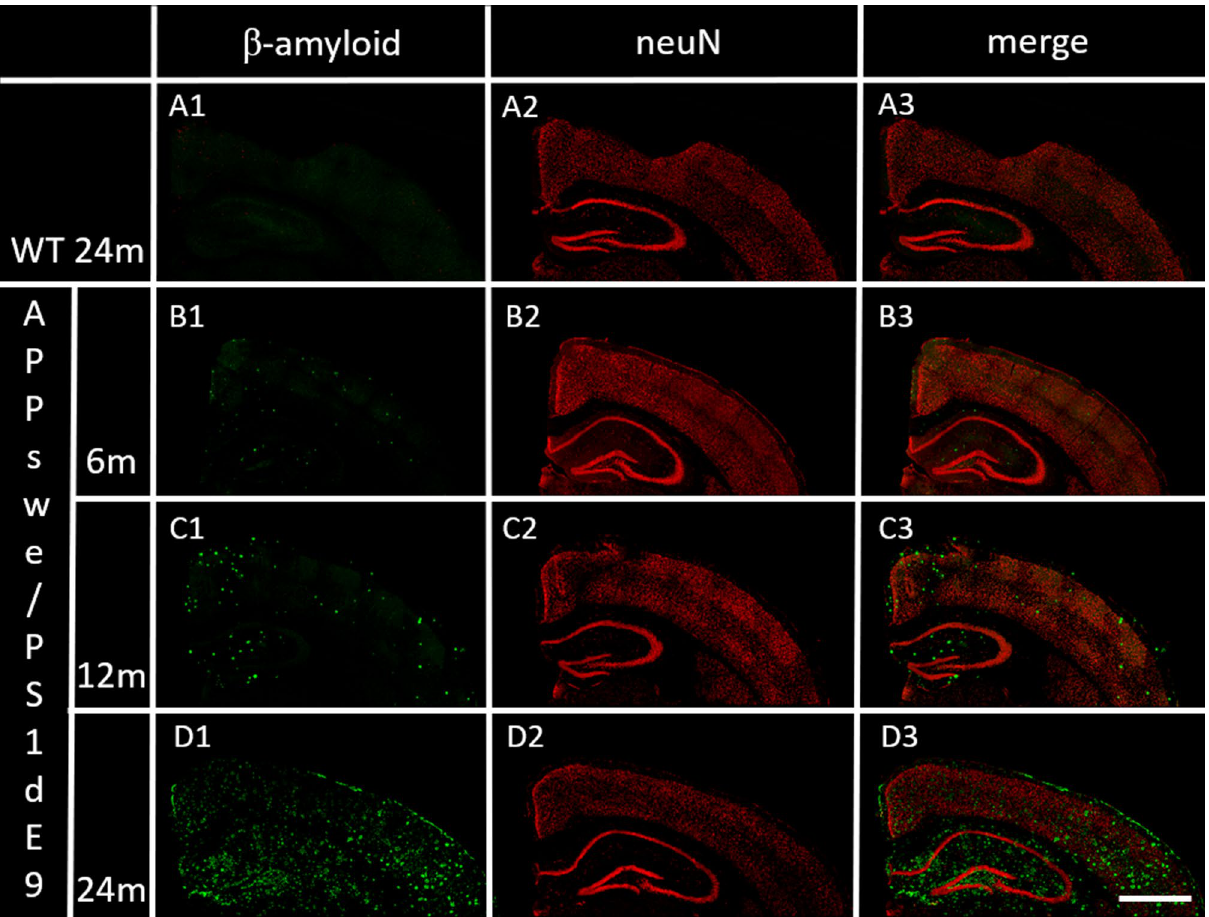
Figure 3. Distribution in cortex and hippocampus of Aβ deposits and neuN, in WT and APPswe/PS1dE9 mice at 6-, 12- and 24-months of age (representative images). (A1) Aβ deposits in 24-month old WT mouse. (B1,C1,D1) age-dependent Aβ deposits in APPswe/PS1dE9 Tg mice. (A2) neuN in 24-month old WT mouse. (B2,C2,D2) age-dependent neuN in APPswe/PS1dE9 Tg mice. (A3,B3,C3,D3) previous merged images. Coronal section 50 µm (×20). Anti-Aβ (green), anti-neuN (red). Bar 1